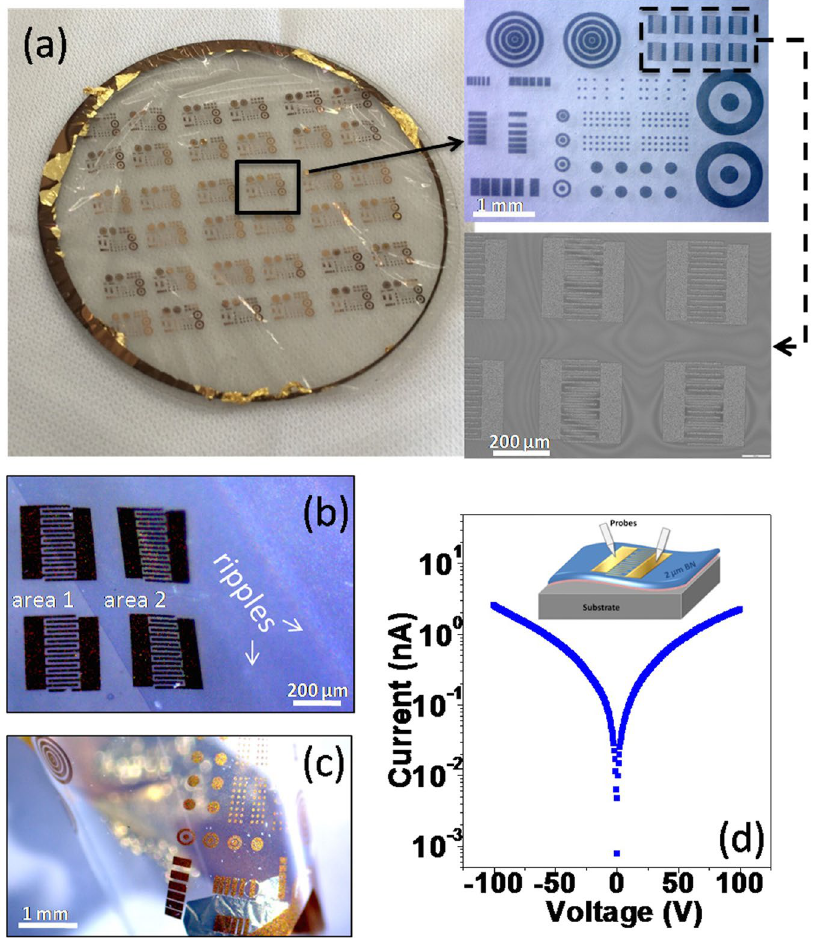
Figure 5. ( a ) BN wafer after device fabrication. Insets are microscope image of the metal contact patterns and scanning electron microscopy image of interdigitated electrodes. ( b ) Microscope image showing the local part where the film was separated from the substrate (area 2). ( c ) A small piece of freestanding BN prototype membrane lifted by tweezers which folded presenting the flexibility of the film. ( d ) Typical dark current-voltage (I-V) characteristics of the fabricated device prototypes and inset is the schematic of the